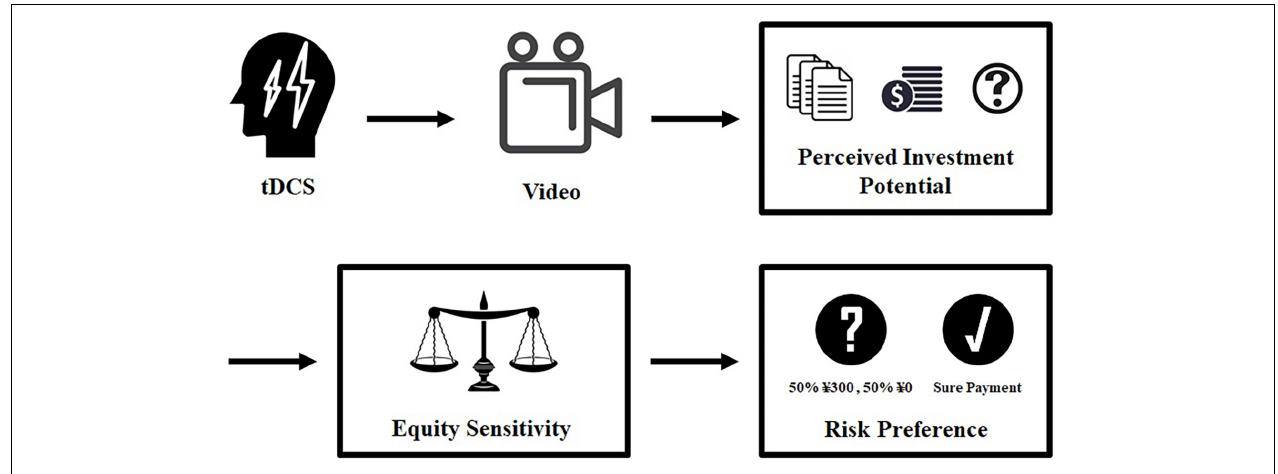
FIGURE 2 | The flow chart of the experimental procedure.